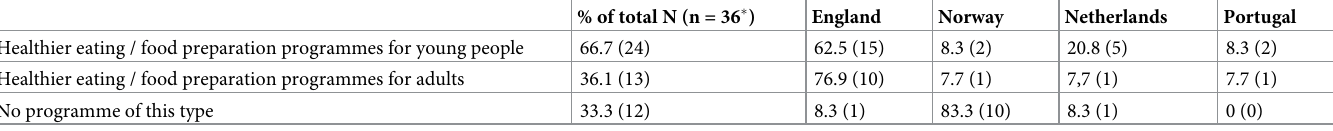
Table 3. Frequency of healthy eating programmes delivered in professional football clubs in four European countries.